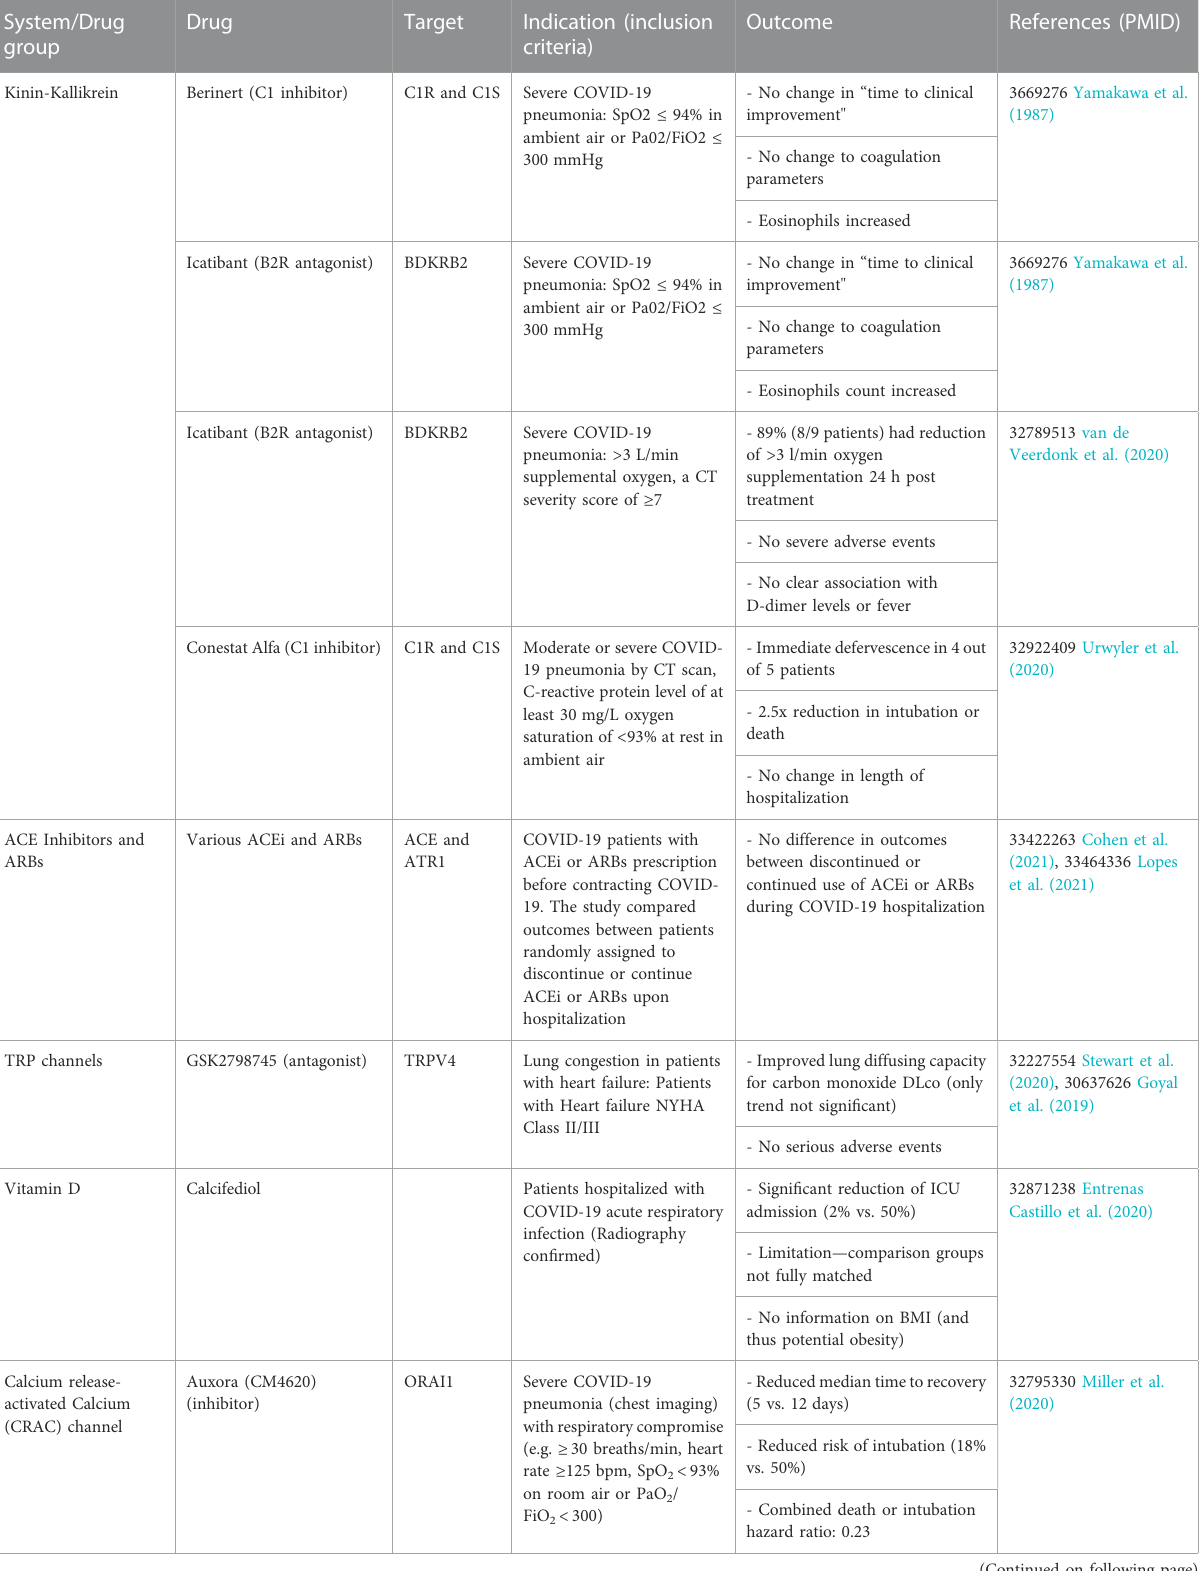
TABLE 1 Readouts of COVID-19 trials utilizing drugs that have the potential to increase ACE2 expression in the context host response (Chee et al.,